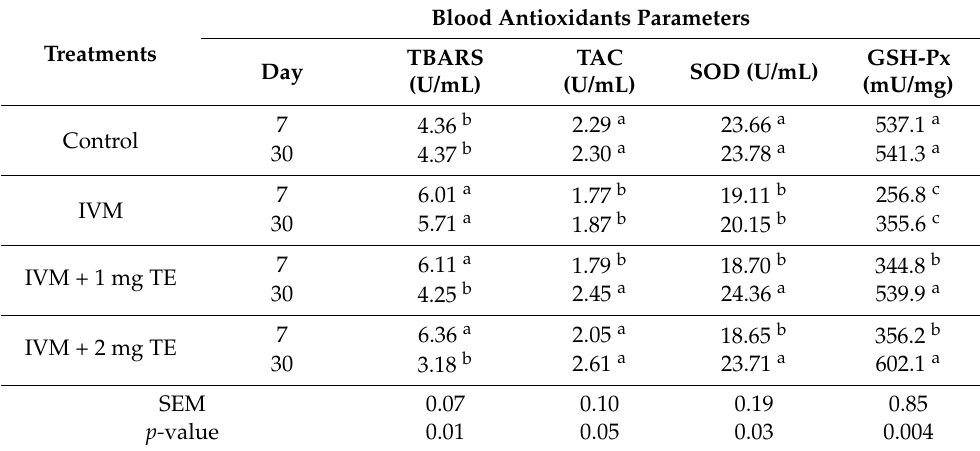
Table 6. The effect of combining Ivermectin injection with turmeric extract supplementation on the serum antioxidants